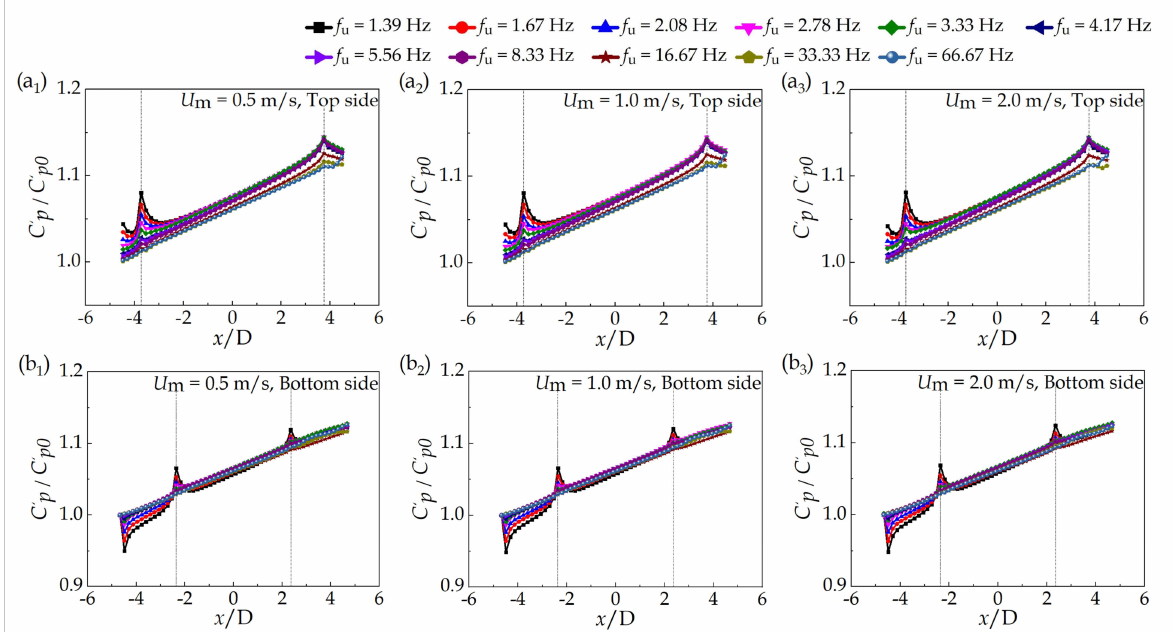
Figure 8. Normalized RMS pressure coefficients in the streamwise sinusoidal oscillating flows: ( a 1 ) U m = 0.5 m/s, top side; ( a 2 ) U m = 1.0 m/s, top side; ( a 3 ) U m = 2.0 m/s, top side; ( b 1 ) U m = 0.5 m/s, bottom side; ( b 2 ) U m = 1.0 m/s, bottom side; ( b 3 ) U m = 2.0 m/s, bottom